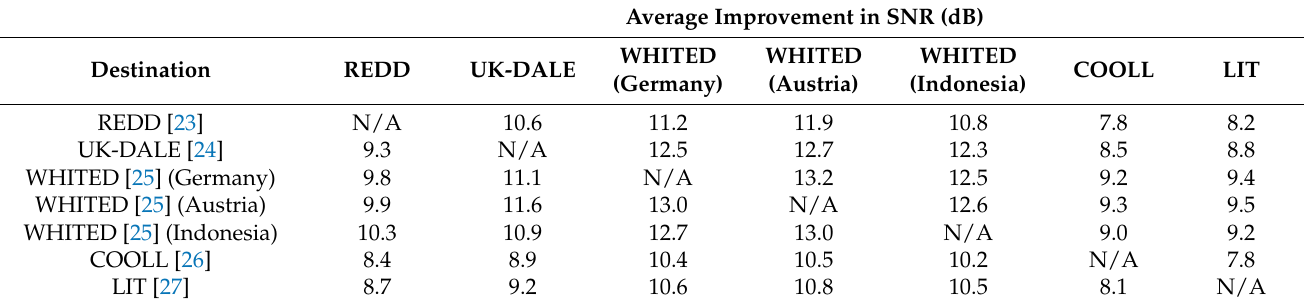
Table 2. Average improvement in signal-to-noise ratio (SNR) using the proposed NSGA-III-optimized OCEEMD–WPT. Average Improvement in SNR (dB)